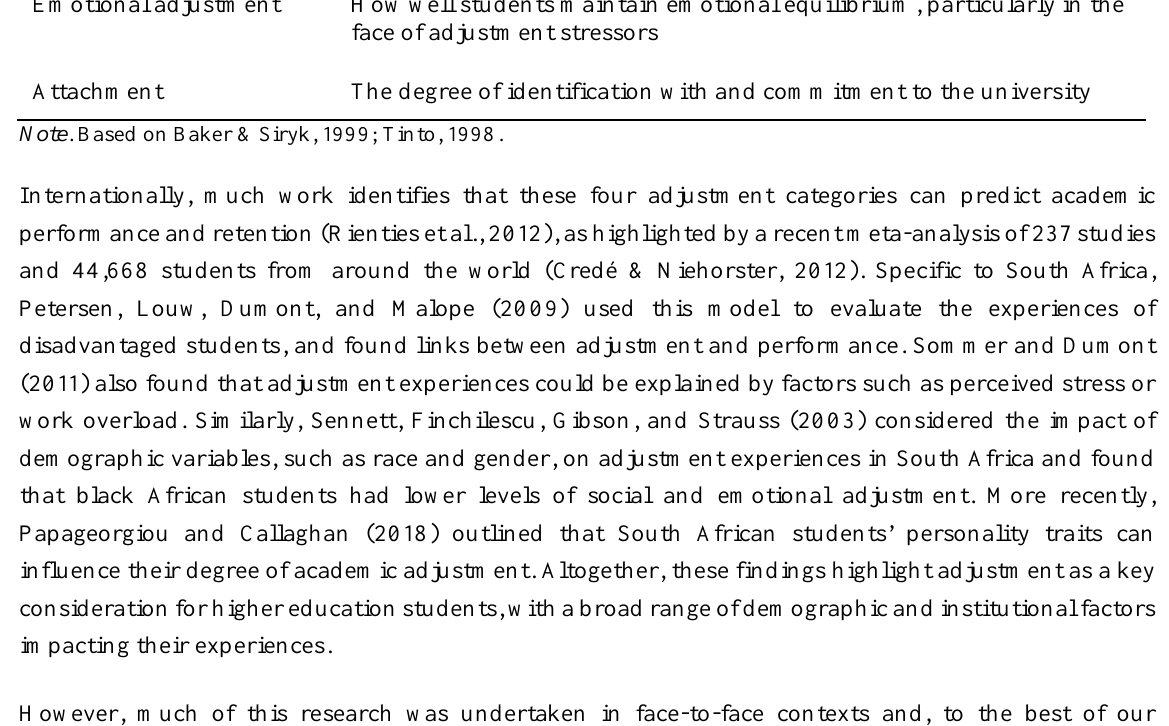
Defined Categories of Student Adjustment Category Definition Academic adjustment How well students manage the educational demands of the university experience Social adjustment How well students deal with interpersonal experiences at the university (e.g., making friends, joining groups) Emotional adjustment How well students maintain emotional equilibrium, particularly in the face of adjustment stressors